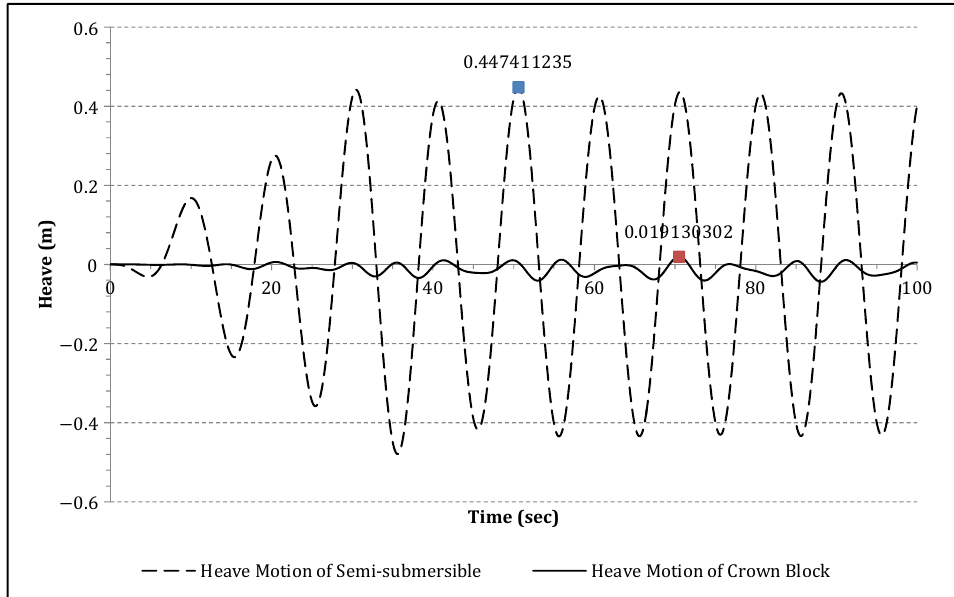
Figure 21. Heave motions of the semi-submersible and crown block for a 16.550 × 1.8-m 3 APV. The larger the APV volume, the higher is the efficiency of the DSC. When the volume reaches V G ,0 × 1.8 L, the state of the crown block becomes neutral and its restoring force disappears, so it can be considered dangerous. From the above results, we can confirm that the results of the simulation based on multibody dynamics can be utilized for determining the limit and optimum value of the APV